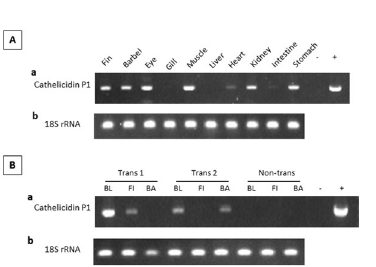
Figure 6. Expression of alligator cathelicidin mRNA from the dsDNA-zebrafish ubiquitin-alligator cathelicidin construct in ( A ) different tissues and ( B ) tissues biopsied non-lethally from P 1 transgenic channel catfish ( Ictalurus punctatus ), as measured by regular RT-PCR followed by agarose gel electrophoresis. Trans 1 and Trans 2 were P 1 transgenic fish and Non-trans was a non-transgenic fish. BL blood, FI fin, BA barbel; + , plasmid DNA positive control; -, PCR reaction in the absence of plasmid DNA. 18S rRNA gene was used as an internal control. Gel electrophoresis images were cropped and full-length gels are presented in Supplementary Figure